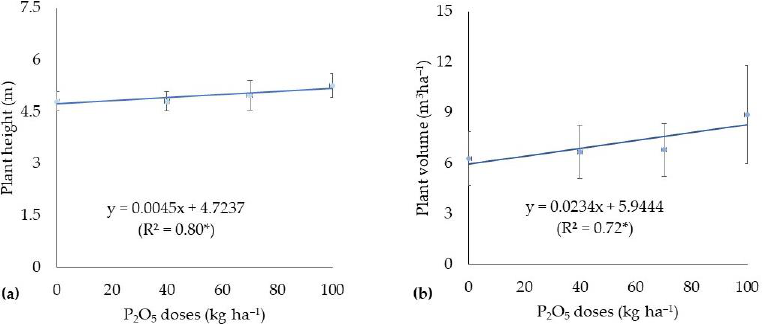
Figure 6. ( a ) Height of eucalyptus five months after definition of eucalyptus shoots as a function of residual P 2 O 5 doses. ( b ) Total volume of eucalyptus wood five months after definition of eucalyptus sprouts as a function of residual P 2 O 5 dose. Each point located on each graph is the mean of five replications. * and ** = significant at 5 and 1% level by F test, respectively.